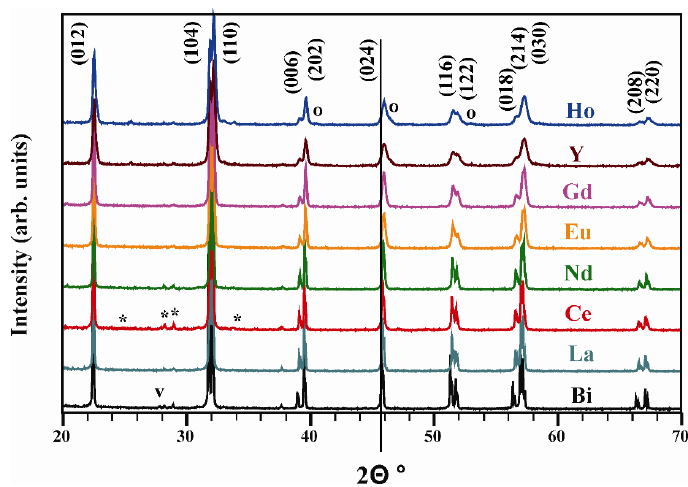
Figure 1. X-ray diffraction patterns for perovskite samples prepared by solution combustion synthesis. Rhombohedral peaks belonging to the R3c space group are indexed; * (star) indicates the impurity phase Bi 2 Fe 4 O 9 , v indicates Bi 25 FeO 39 , and o denotes distinguishable peaks associated with the orthorhombic Pnma perovskite phase. The polyhedral presentation of the crystal structure is given in Figure 2. Bi has an “umbrella”-like coordination with nine oxygen ions, while Fe is in distorted octahedral coordination. The A- and B-cation shift is clearly seen. The position of lone electron pair (LEP) is presented schematically. The detailed structural parameters for all samples in the series are given in Table 2. The Rietveld plot of one of the samples, namely, Bi 0.9 Eu 0.1 FeO 3 is presented in Figure 3. The Rietveld plots for other samples can be seen on Figures S9–S15 in the Supplementary Materials. Table 3 represents a list of selected interatomic distances in the refined crystal structures.